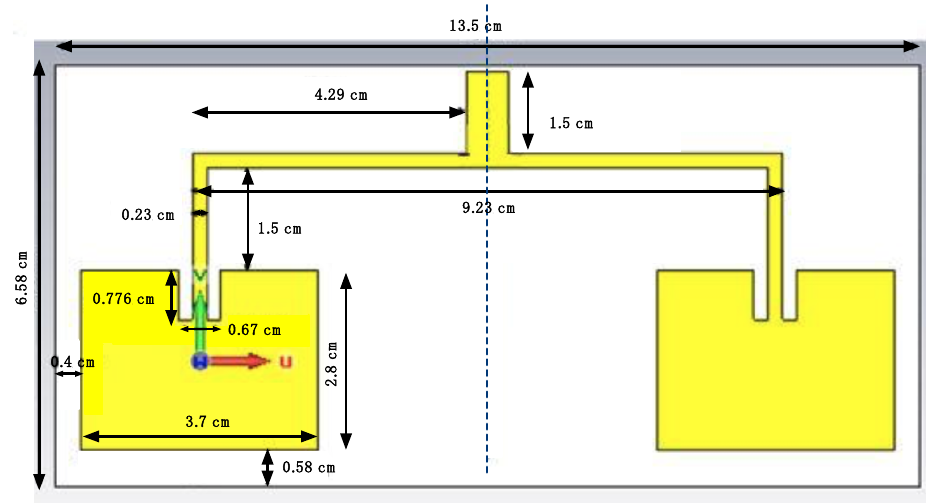
Figure 8. 2 × 1 array dimensions.